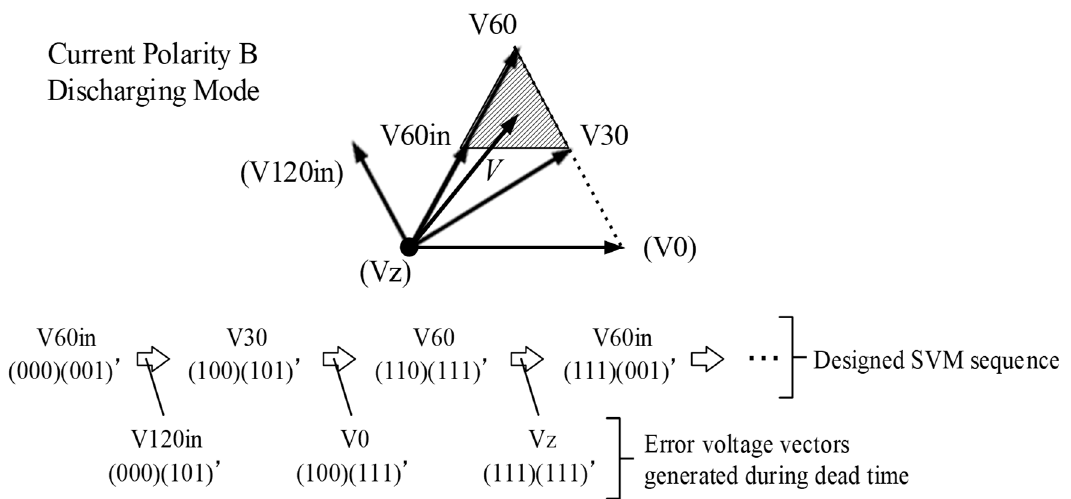
Figure 10. Error voltage vectors during dead time of synchronously turn on or off.